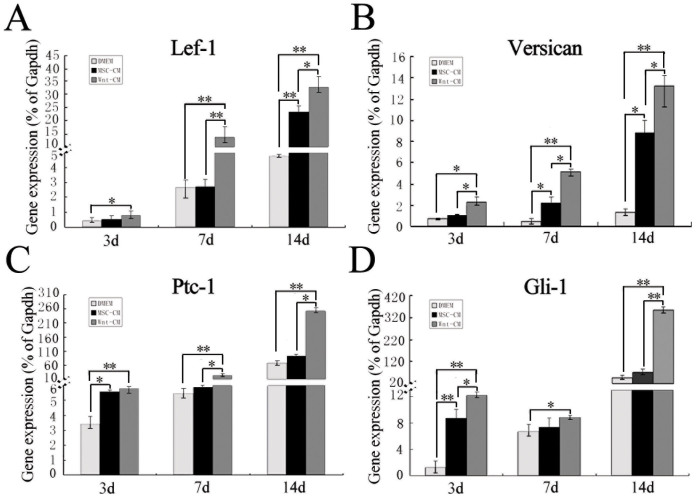
Hair follicle induction-related gene expression in the dorsal skin of mice.qRT-PCR analysis revealed the expression levels of genes of Lef-1 (A), Versican (B), Ptc-1 (C), and Gli-1 (D) in the dorsal skin of mice. The data represent the means ± SEM, n = 3. Statistically significant at *P < 0.05 and **P < 0.01.